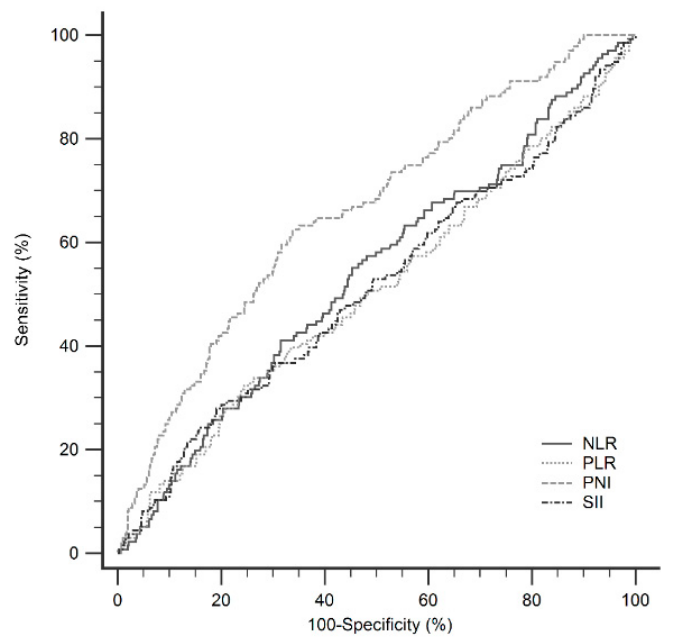
Figure 2. Comparisons of the areas under the curve (AUC) for outcome predictions in patients after